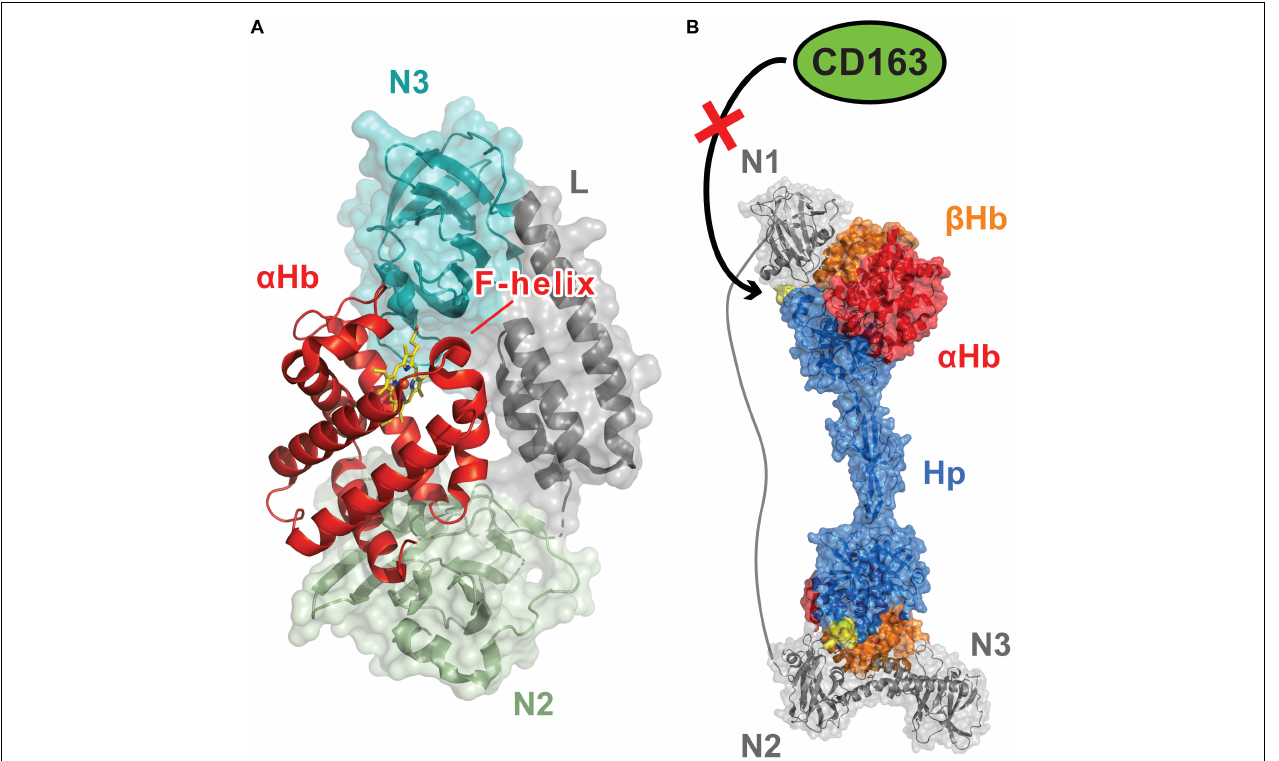
FIGURE 2 | Dedicated Hemoglobin (Hb)-binding NEAT domains enable S. aureus to capture Hb and extract its heme molecules. (A) Structure of the S. aureus IsdH protein bound to Hb [PDB: 4XS0, (Dickson et al., 2015)]. IsdH and IsdB are Hb receptors that extract heme using a conserved tri-domain unit (shown in Figure 1A ). Each unit engages a single globin chain and contains a dedicated Hb-binding N-terminal NEAT domain that binds to the globin’s A-helix and a C-terminal NEAT domain then removes the heme molecule via distortion of the Hb F-helix. The tri-domain unit in IsdH contains Hb-binding (N2, green) and heme-binding (N3, teal) NEAT domains, connected by a helical linker domain (L, gray). Synergistic interactions between the NEAT domains trigger heme release from Hb. The IsdB and IsdH tri-domain units bind to Hb in a similar manner and share related primary sequences. (B) Model showing how the multiple NEAT domains within the IsdH receptor may prevent haptoglobin (Hp) mediated removal of Hb from the blood, a nutritional immunity process that limits microbial access to iron [PDB: 4WJG, (Stodkilde et al., 2014) 6TB2, (Mikkelsen et al., 2020)] (Figure adapted from Mikkelsen et al., 2020). The tri-domain unit in IsdH is elaborated with a N-terminal Hb-binding